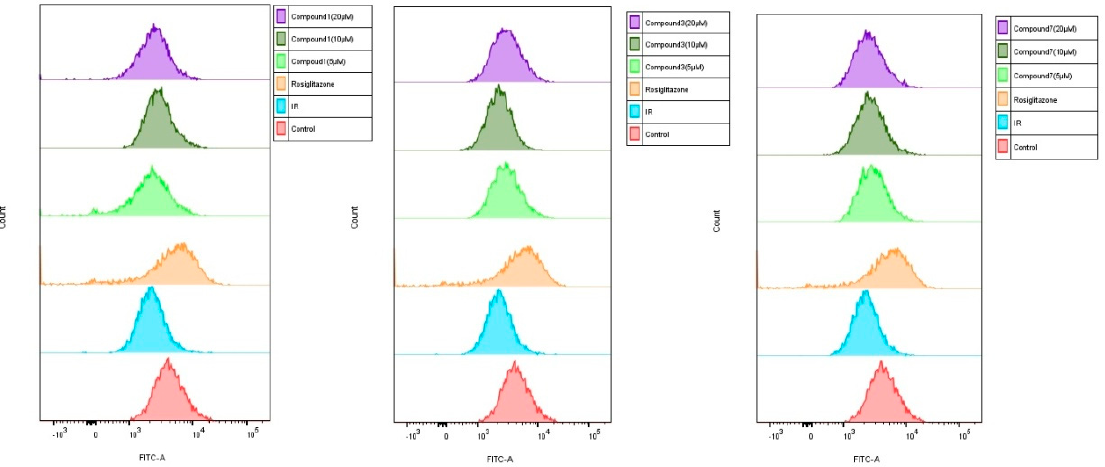
Figure 6. Effect of compounds 1 , 3 and 7 on glucose uptake in insulin-induced HepG2 cells ( 𝑥̅ ± s, n = 4). The 2-NBDG fluorescence measured by flow cytometry.